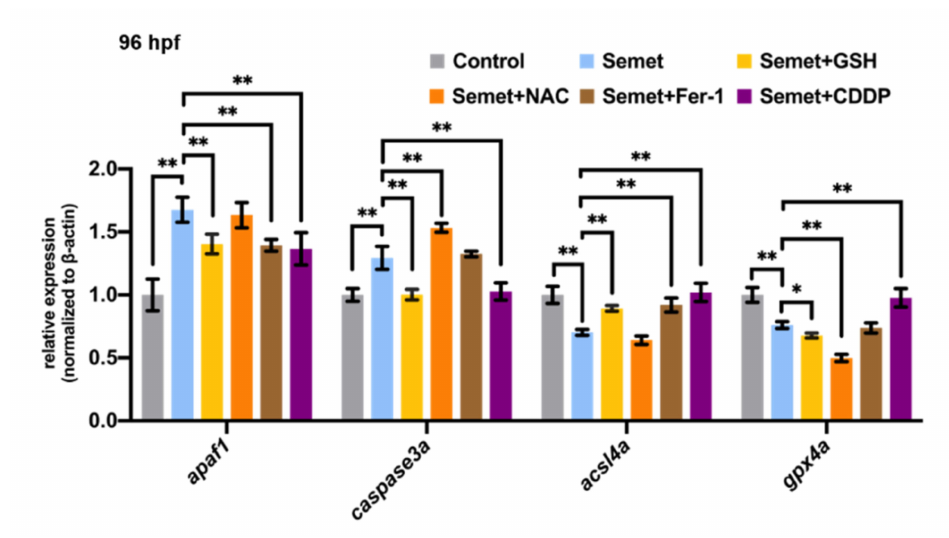
Figure 7. Effects of GSH, Fer-1, NAC and CDDP on ferroptosis and apoptosis in selenium-treated embryos at 96 hpf. **, P < 0.01; *, P <